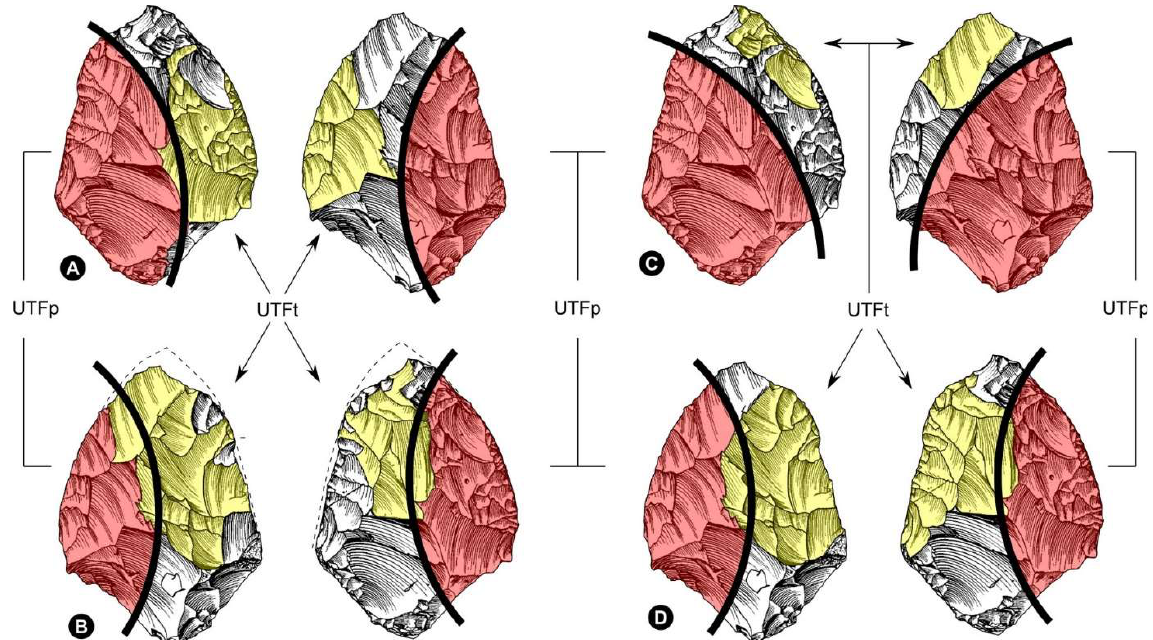
Figure 12. Détermination des unités technicofonctionnelles dans la structure de la pièce bifaciale proventant de la couche C’3 base du site de Barbas I, Dordogne. En rouge, la zone fonctionnelle à rôle préhensif (UTFp); en jaune, la zone fonctionnelle à rôle transformatif (UTFt). La relation des deux UTF, évaluée au niveau individuel et au niveau de l’ensemble lithique, a permis d'identifier quatre outils (A-D) au sein d'une même pièce bifaciale. Comme il est évident, certaines zones ont une double fonction au sein de la même structure (Modifié de Boëda 2001: 72, figures